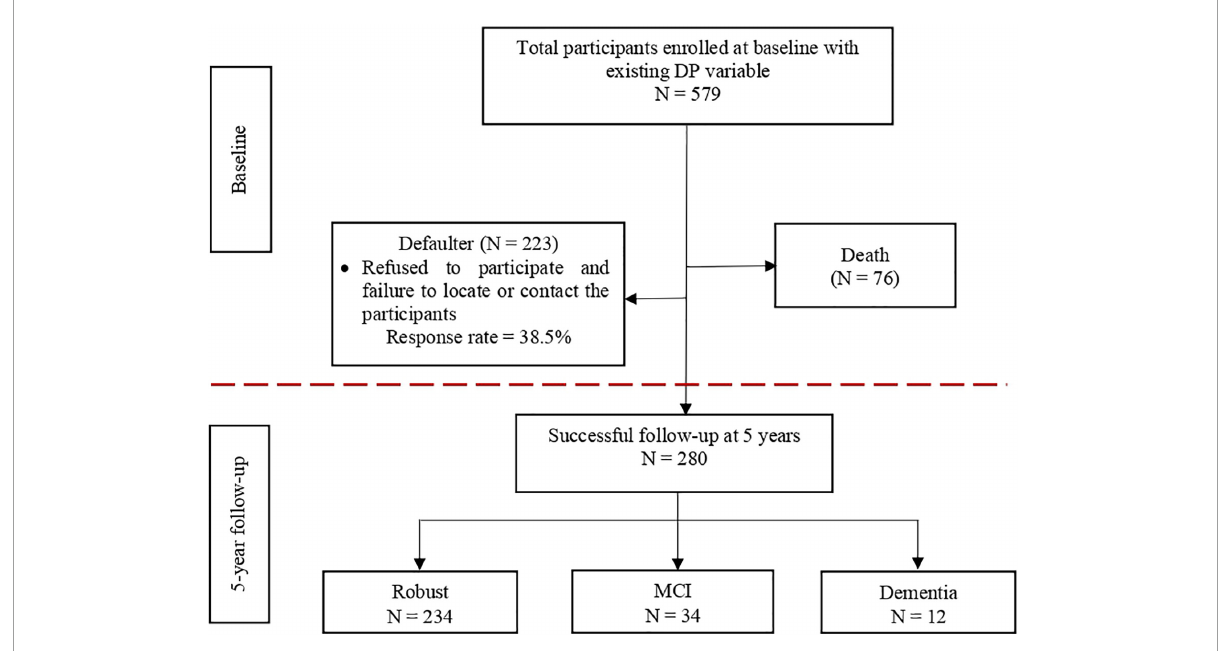
FIGURE1 Illustration of the number of participants from the baseline to the 5-year follow-up incidence of MCI and